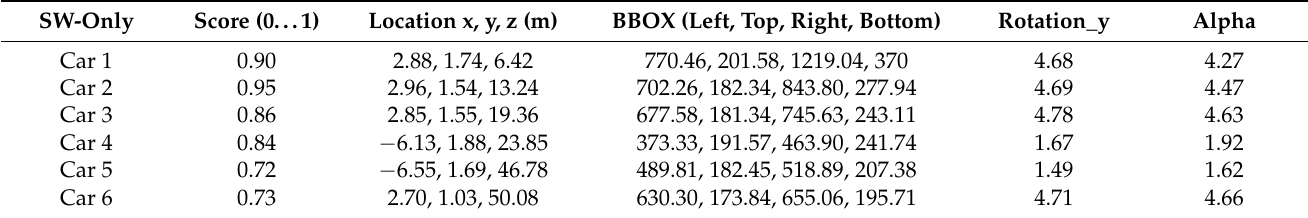
Table 2. Software only model version metrics for the evaluated frame.